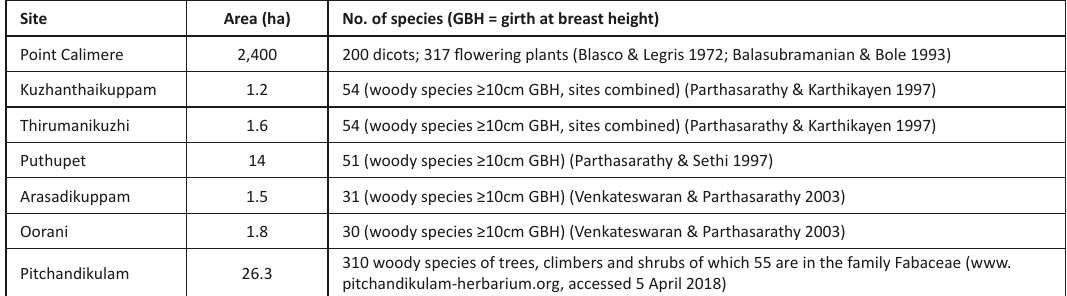
Table 1. Areas and proportions of growth forms recorded in the literature, after Venugopal et al. (2008) with the additions of information from the Pitchandikulam Forest